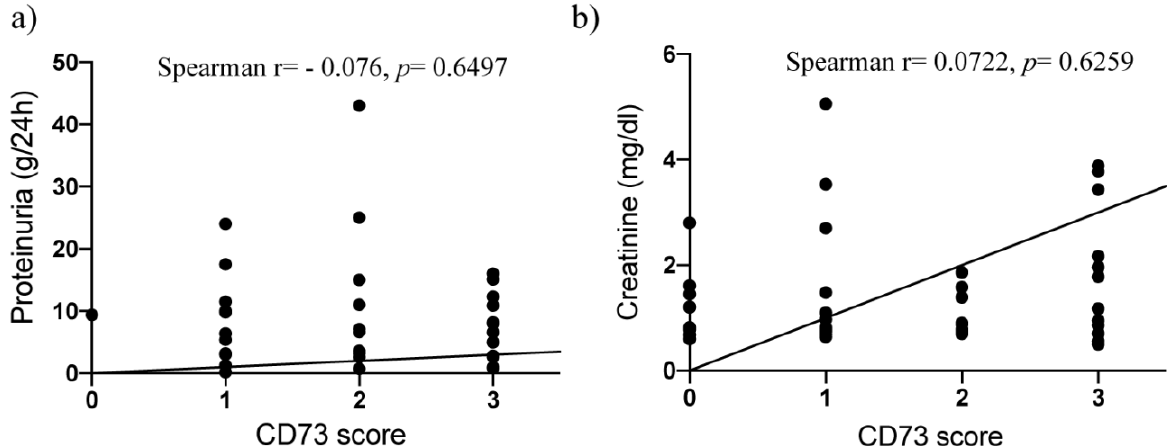
Figure 3. XY graph of correlation between CD73 score, ( a ) proteinuria (g/24 h) and ( b ) creatinine (mg/dL) levels. Spearman non-parametric correlation test; n = 38 (proteinuria—podocyte lesion group) and n = 48 (creatinine—all patients); two-tailed p value, confidence interval 95%. p > 0.05—no significant correlation.